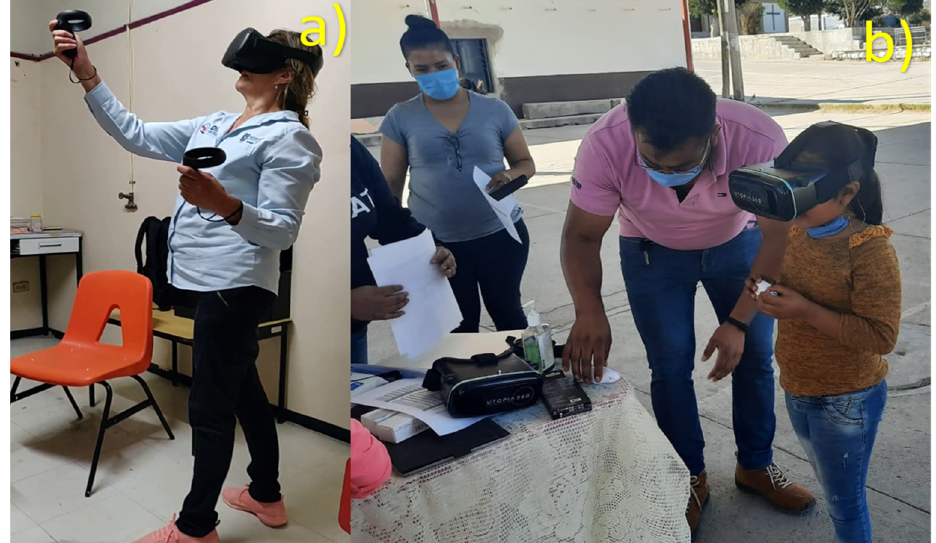
Figure A2. Technological prototypes used in the educational virtual reality environments.